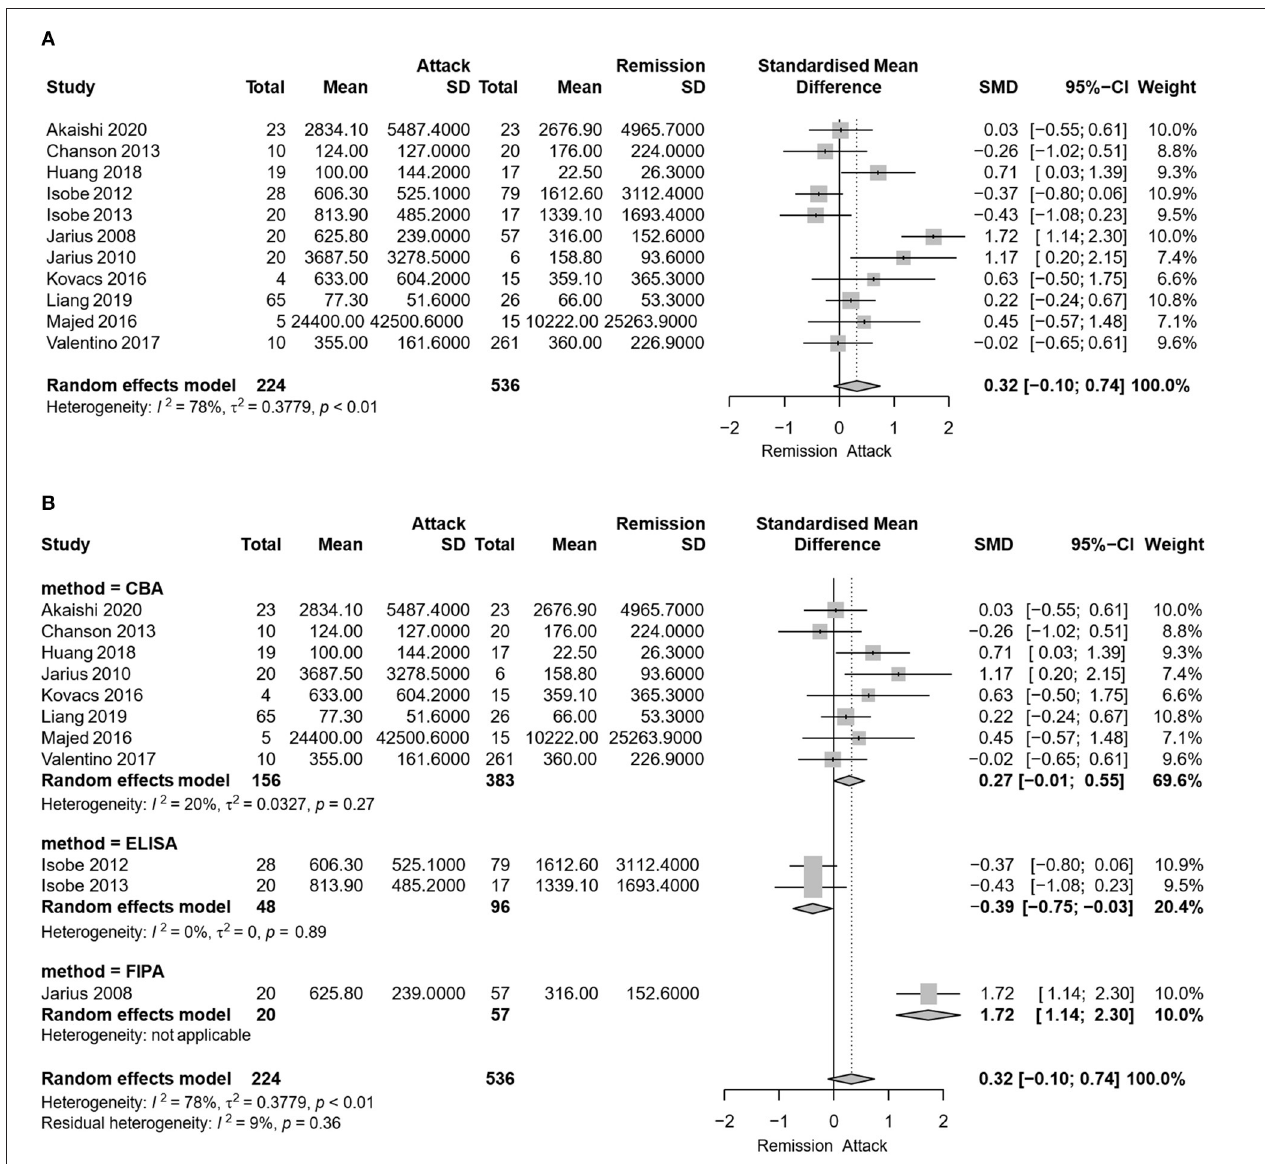
FIGURE 2 | Meta-analysis of the serum aquaporin 4-immunoglobulin G (AQP4-IgG) titer between the attack and remission phase for patients with neuromyelitis optica spectrum disorder (NMOSD). (A) Meta-analysis of the serum AQP4-IgG titer between the attack and remission phase for patients with NMOSD. (B) Subgroup meta-analysis of the serum AQP4-IgG titer between the attack and remission phase for patients with NMOSD according to the antibody detection methods. AQP4-IgG, aquaporin4-IgG; CBA, cell-based assay; ELISA, enzyme linked immunosorbent assay; FIPA, fluorescence-based immunoprecipitation assay; NMOSD, neuromyelitis optica spectrum disorder; SD, standard deviation; 95% CI, 95% confidence interval.